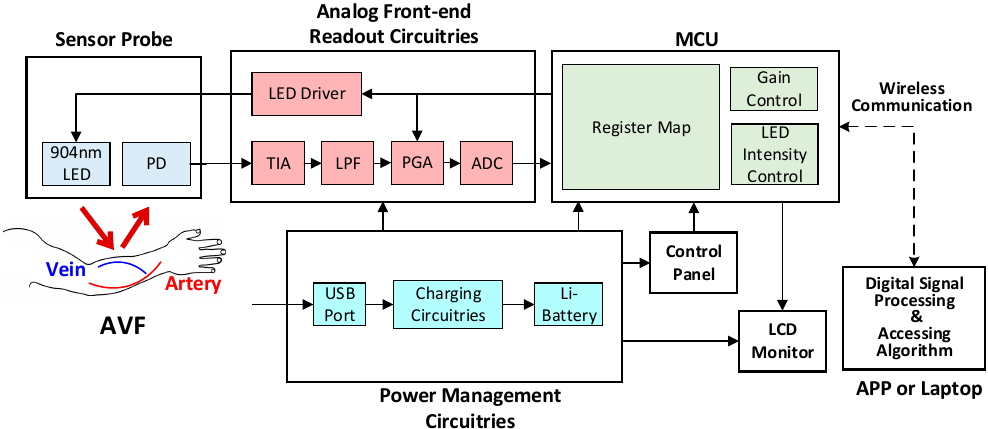
Figure 3. The system architecture of the proposed wireless PPG sensor system.